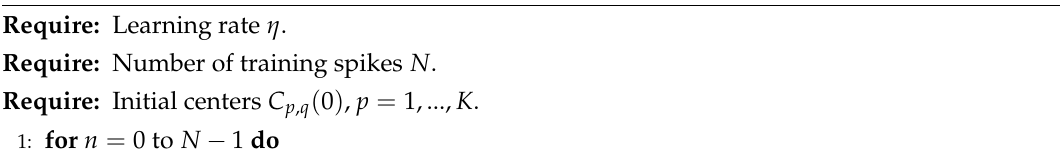
Algorithm 1 CL algorithm for spike clustering of channel q by N training spikes